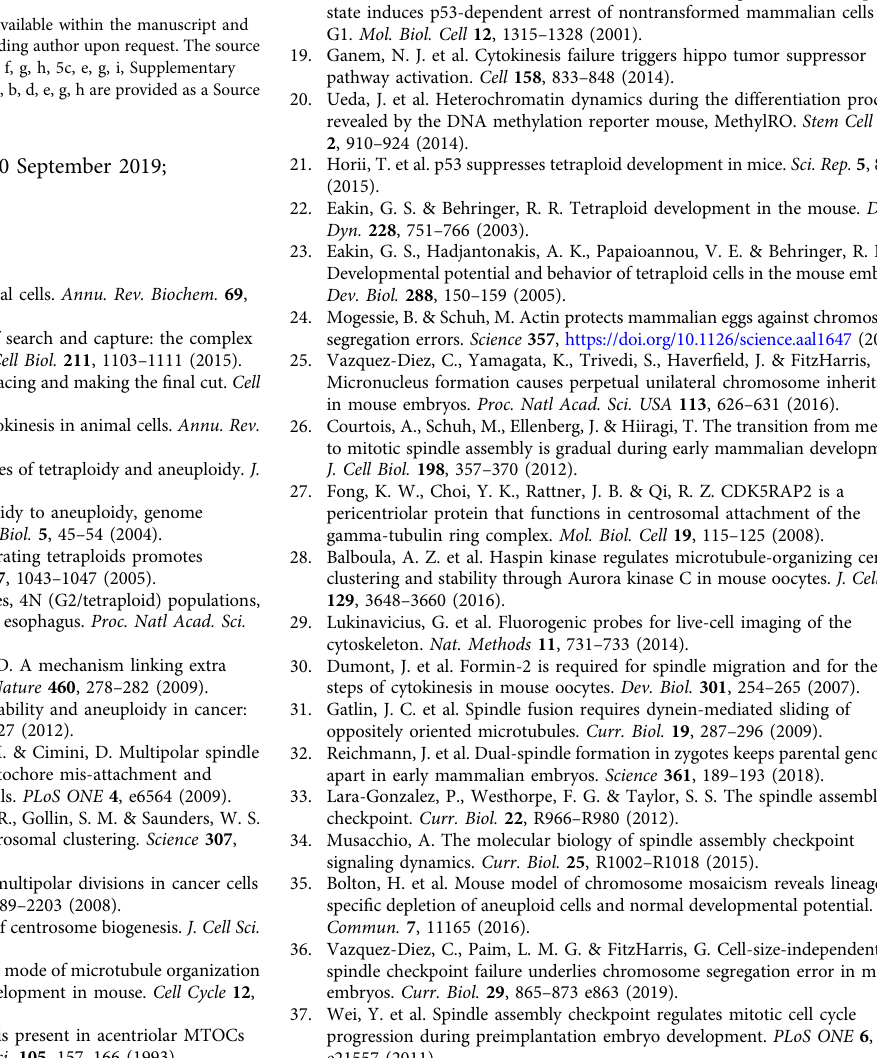
Fig. 5 Error correction mechanisms are defective in tetraploid embryos. a PAGFP-tubulin (inverted grey) was photoactivated at a rectangular region across one side of the metaphase spindle (red rectangles) and the time-course for fl uorescence decay was monitored. Embryos were labelled with SiR Tubulin (grey) to identify the metaphase spindle. b and c Quanti fi cation of fl uorescence decay values b and kinetochore – microtubule half-life ( c ; ** P = 0.008, unpaired, two-tailed t test) in 16-cell control ( n = 11 blastomeres) and 8-cell tetraploid embryos ( n = 9 blastomeres). In the box plot, the centre line represents median, the bounds of box represent upper and lower quartiles and the whiskers represent minimum and maximum values. d Representative z- projections of end-on, merotelic/lateral, and unattached kinetochores at 35 min after nuclear envelope breakdown (NEBD); and scheme illustrating the types of kinetochore – microtubule attachments analysed. Representative images were chosen to demonstrate the different types of attachments. For the merotelic/lateral attachment image, only the merotelically attached kinetochore is in focus (as represented in the illustration by a fainter colour of the sister chromatid). e Average percentage of end-on, merotelic/lateral and unattached kinetochores per cell in 16-cell ( n = 189 kinetochores from fi ve blastomeres) control and 8-cell tetraploid embryos ( n = 223 kinetochores from fi ve blastomeres; * P = 0.0148, unpaired, two-tailed t test). f Representative z-projections of MCAK immuno fl uorescence in 16-cell control and 8-cell tetraploid embryos. g Quanti fi cation of fl uorescence intensity in 16-cell control and 8-cell tetraploid embryos ( n = 100 kinetochores from 10 blastomeres per group). Statistical analysis was performed as an inter-embryo comparison using the average from 10 individual kinetochores analysed per blastomere, * P = 0.0223 (unpaired, two-tailed t test). h Representative time-lapse images of 8-cell tetraploid embryos co-expressing H2B:RFP and either GFP or MCAK:GFP. The yellow arrow indicates a lagging chromosome. i Percentage of cell divisions displaying chromosome segregation errors in 8-cell tetraploid embryos co-expressing H2B:RFP and either GFP ( n = 51 divisions from 16 embryos) or MCAK:GFP ( n = 66 divisions from 23 embryos) ** P = 0.0093 (two-tailed chi-square). Chromosome segregation errors observed included: lagging chromosomes resulting in micronuclei formation (lagging with MN); lagging chromosomes that did not result in micronuclei formation (lagging without MN); and chromosome bridges. Scale bars = 10 µ m, except for d , where scale bars = 1 µ m. Error bars